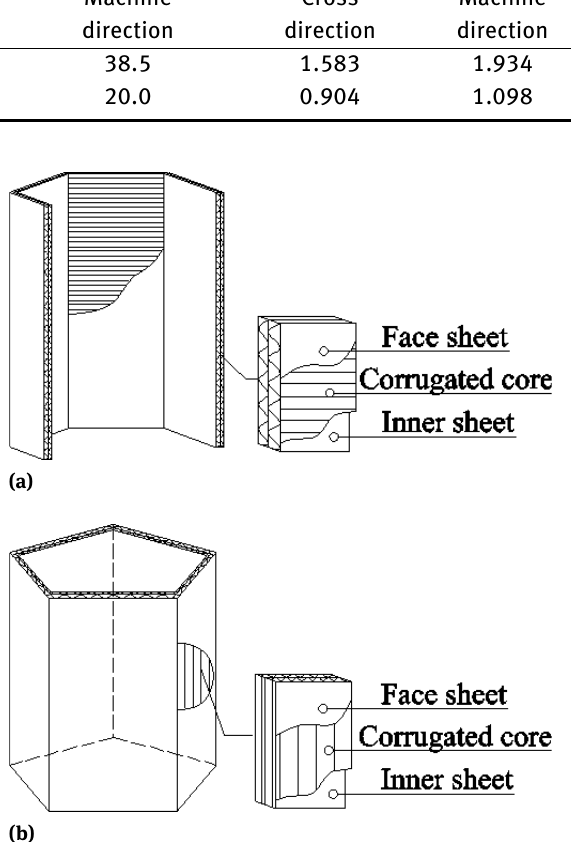
Figure 2: Geometry representation of paper corrugation tubes: (a) tubes along X direction; (b) tubes along Y